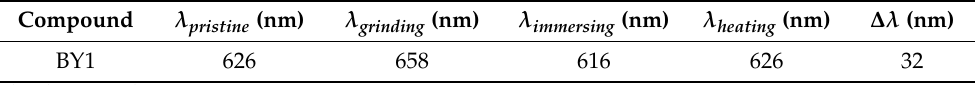
Figure 5. ( A , B ) Switching the light emission of BY1 via grinding, immersing and heating processes. These photos were taken under 365 nm UV light. ( C ) Normalized PL spectra of BY1 in the pristine state, grinding state, and the state after heating at 80 ℃ . ( D ) Normalized PL spectra of BY1 in the pristine state, grinding state, and the state after immersing with acetone. ( E ) The repeated cycles of BY1 via the grinding–heating processes at 80 ℃ . ( F ) The repeated cycles of BY1 via the grinding–immersing processes. ( G ) PXRD of BY1 in different states: pristine, grinding, heating, and immersing with acetone. ( H ) DSC of BY1 in different states: pristine, grinding, heating, immersing with acetone. Table 2. Peak emission wavelengths of solid-state BY1 under different conditions.